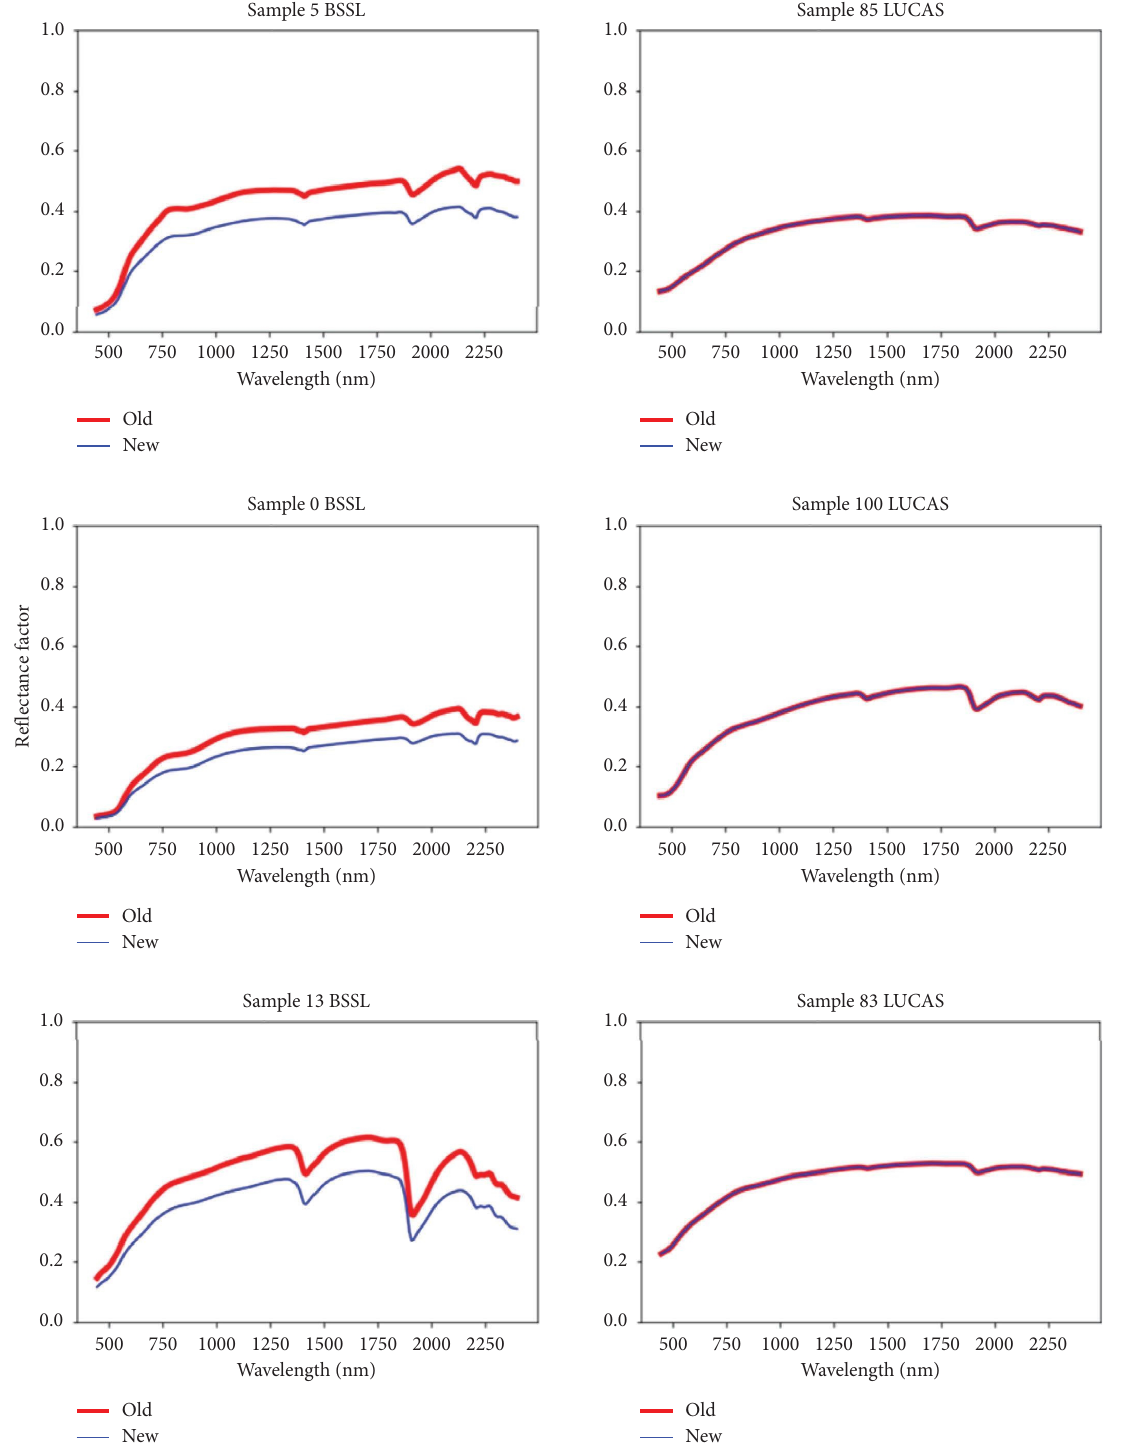
Figure 11: Selected examples of old–original and new spectral responses in the rectifcation groups before any